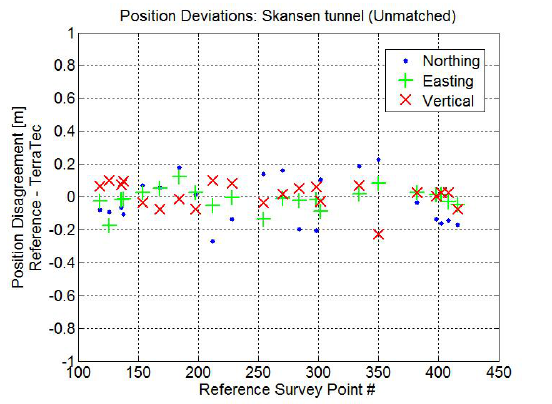
Figure 5: TerraTec system solution deviations relative to the ref- erence measurements, when matching is not utilized, Skansen tunnel.